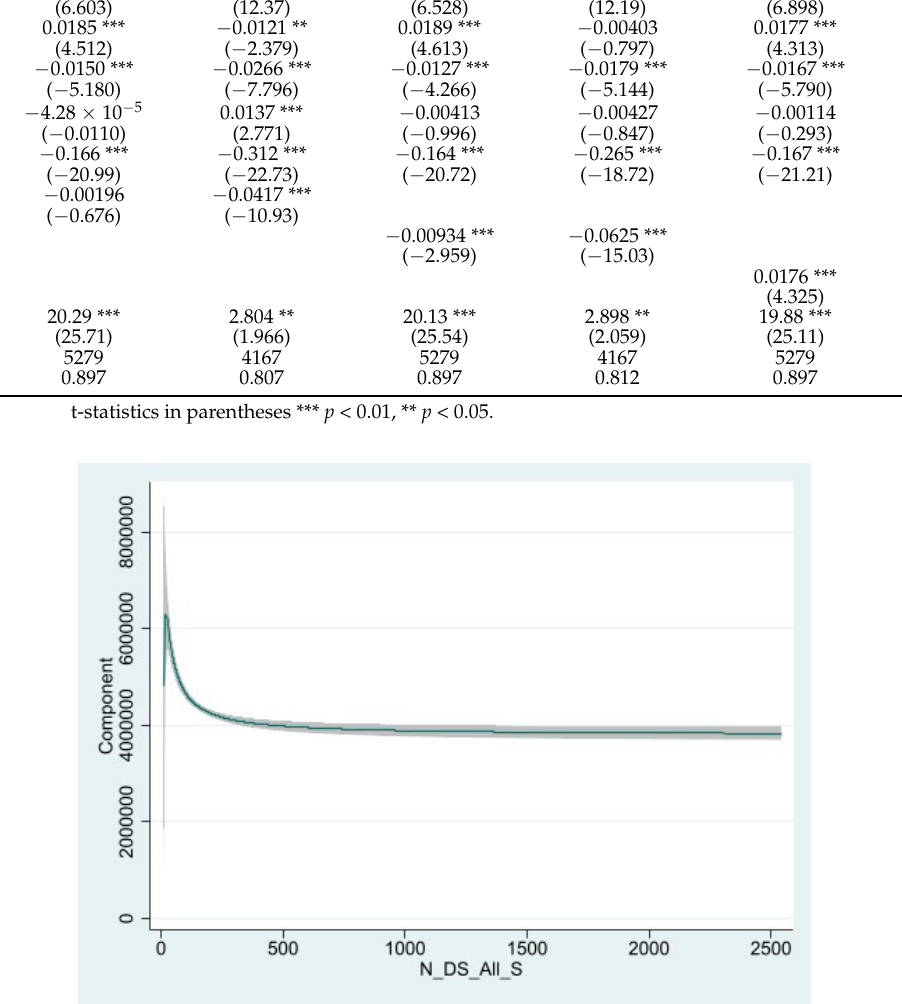
Figure 3. Polynomial